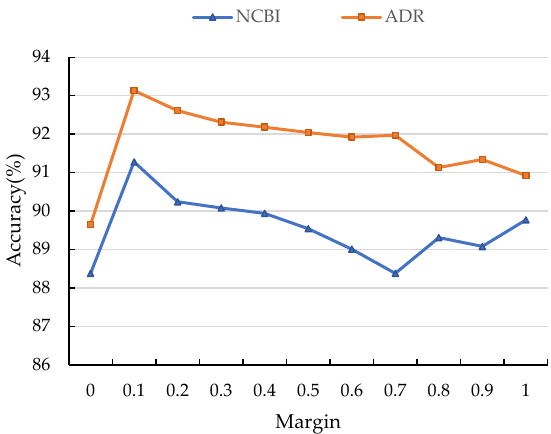
Figure 4. The impact of different margin values.